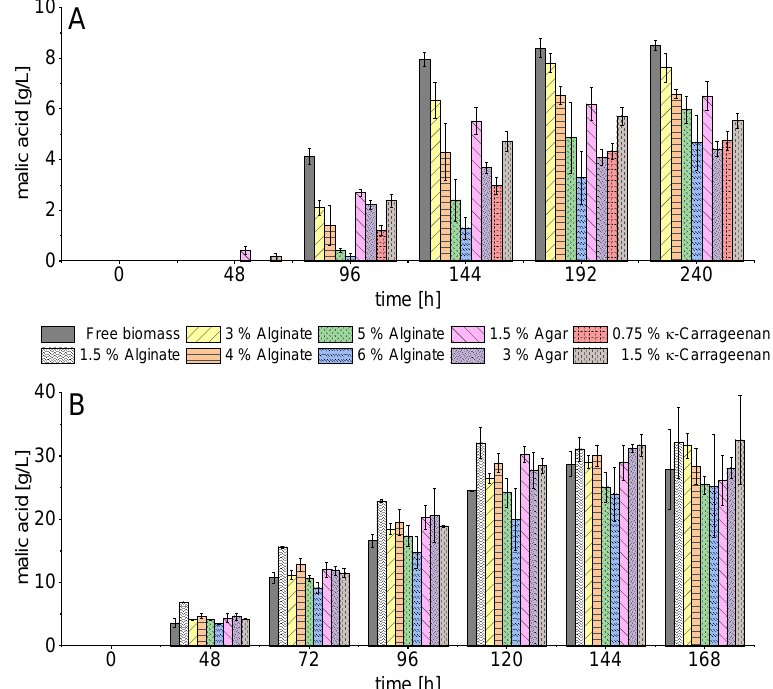
Figure 1. Malic acid production in shake flask cultivations with A. oryzae immobilized in different natural polymers using acetate ( A ) or glucose ( B ) as carbon source. Values are means of triplicates with standard deviation.